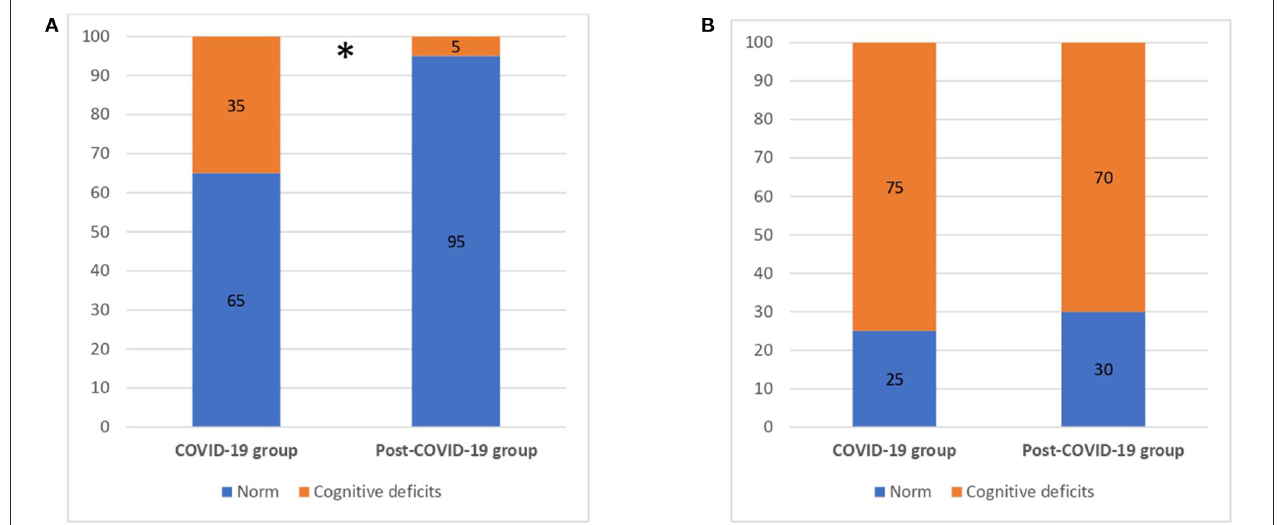
FIGURE 1 | Cognitive deficits for COVID-19 and post-COVID-19 patients. (A) MMSE (total score). (B) MoCA (total score). MMSE, Mini Mental State Examination; MoCA, Montreal Cognitive Assessment; numbers are reported as %. * p < 0.05.